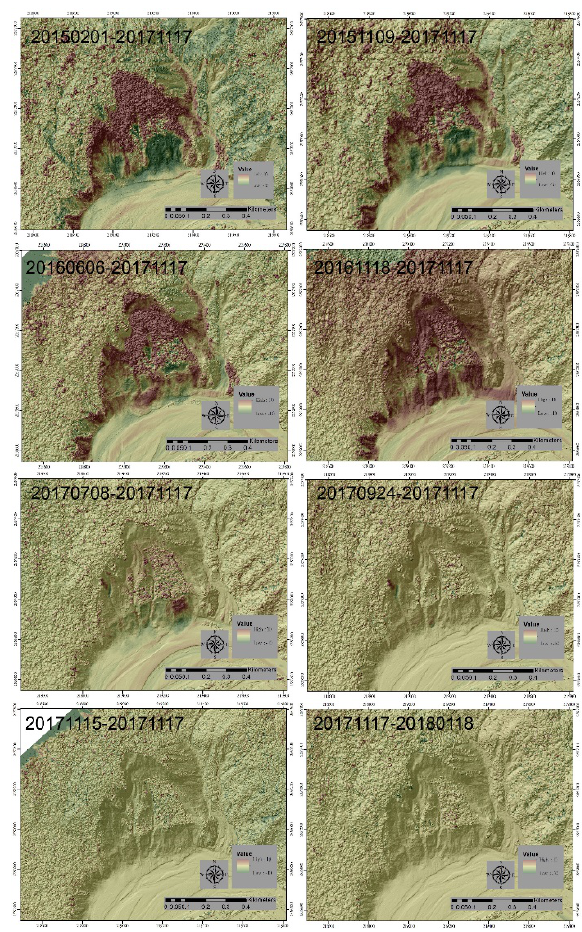
Figure 5. Topographic changes of the landslide